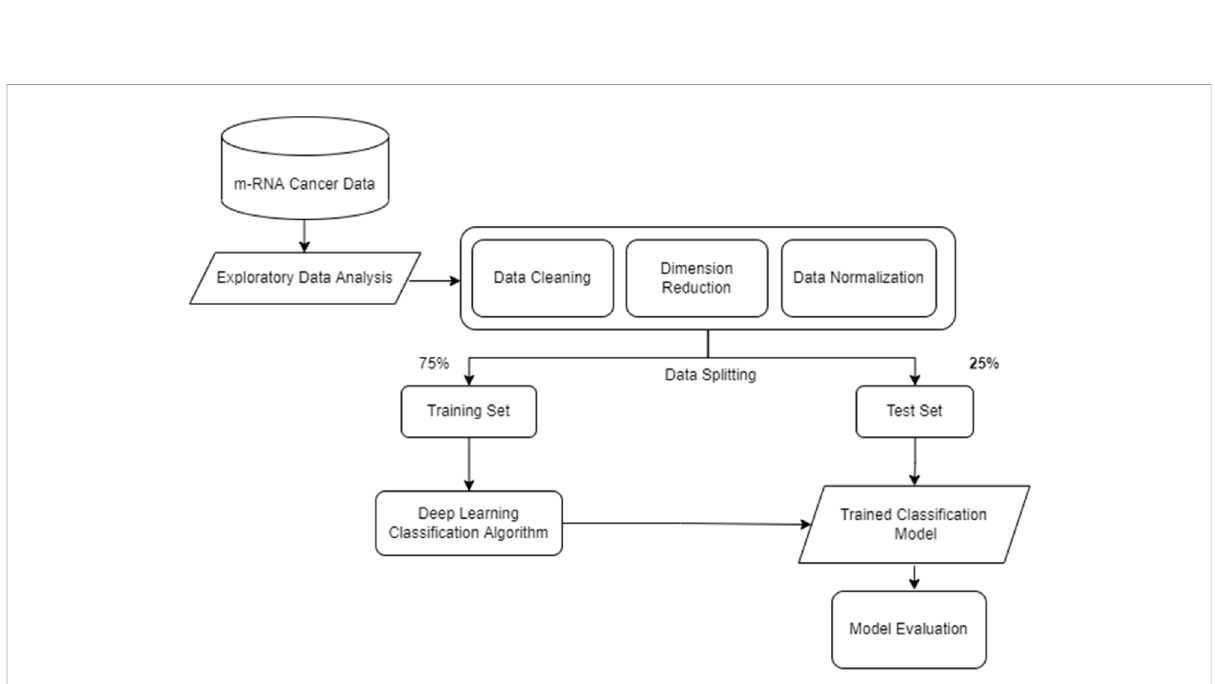
FIGURE 11 Deep learning for Cancer Classi fi